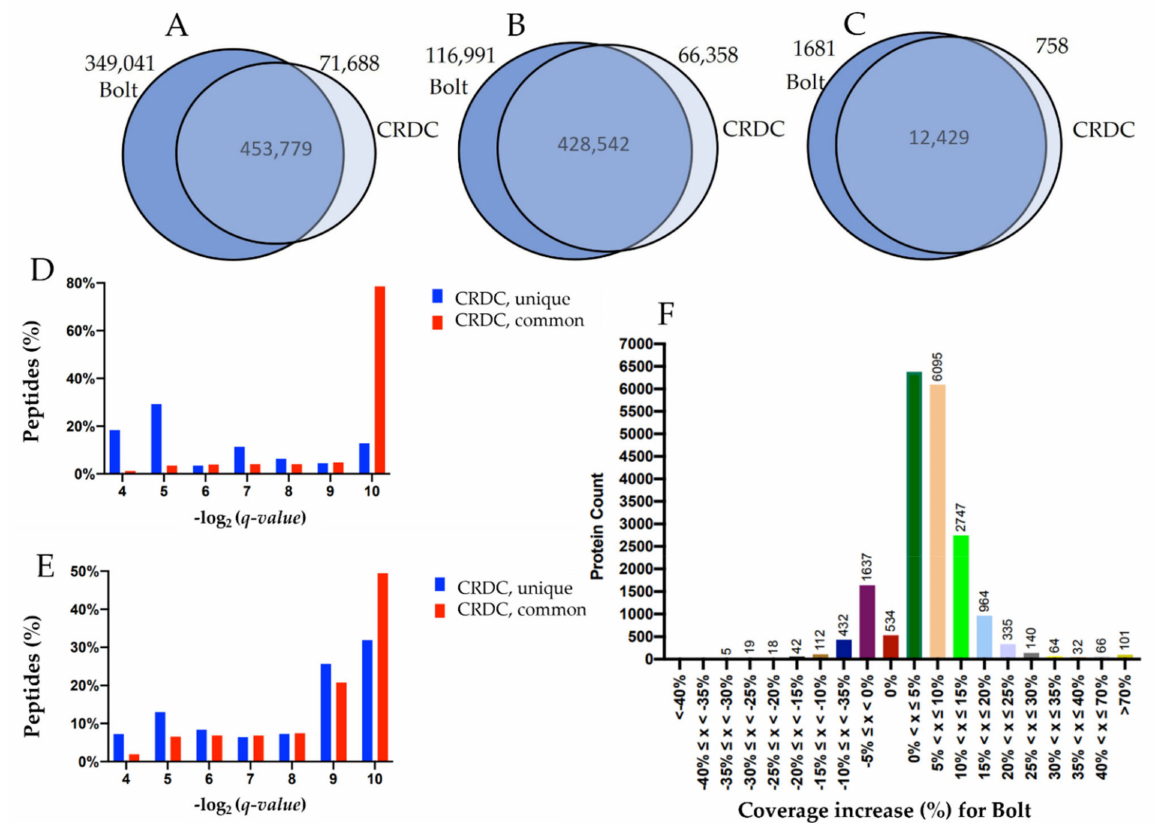
Figure 1. A comparison of Bolt peptide IDs to the original analysis. ( A ) Venn diagram comparing the total number of peptide IDs between the Bolt search results and the CRDC’s search results. ( B ) Venn diagram comparing the total number of unique peptide sequences between the Bolt search results and the CRDC’s search results. ( C ) Venn diagram comparing the total number of SwissProt protein IDs with at least two peptides between the Bolt search results and the CRDC’s search results. ( D ) Distribution of q -values of the CRDC’s unique vs. common peptide results. ( E ) Distribution of q -values of the Bolt’s unique vs. common peptide results. ( F ) Distribution of the protein sequence coverage increase by Bolt compared to